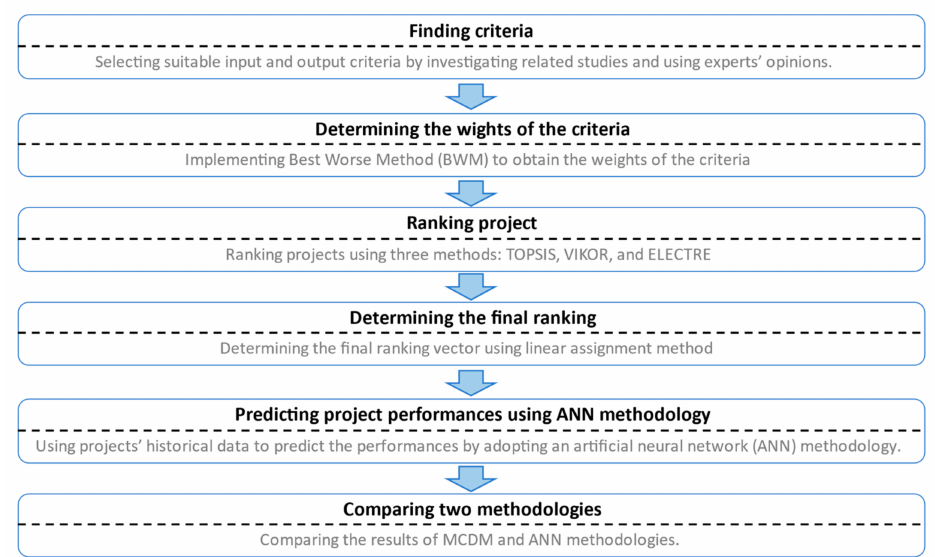
Figure 1. Research